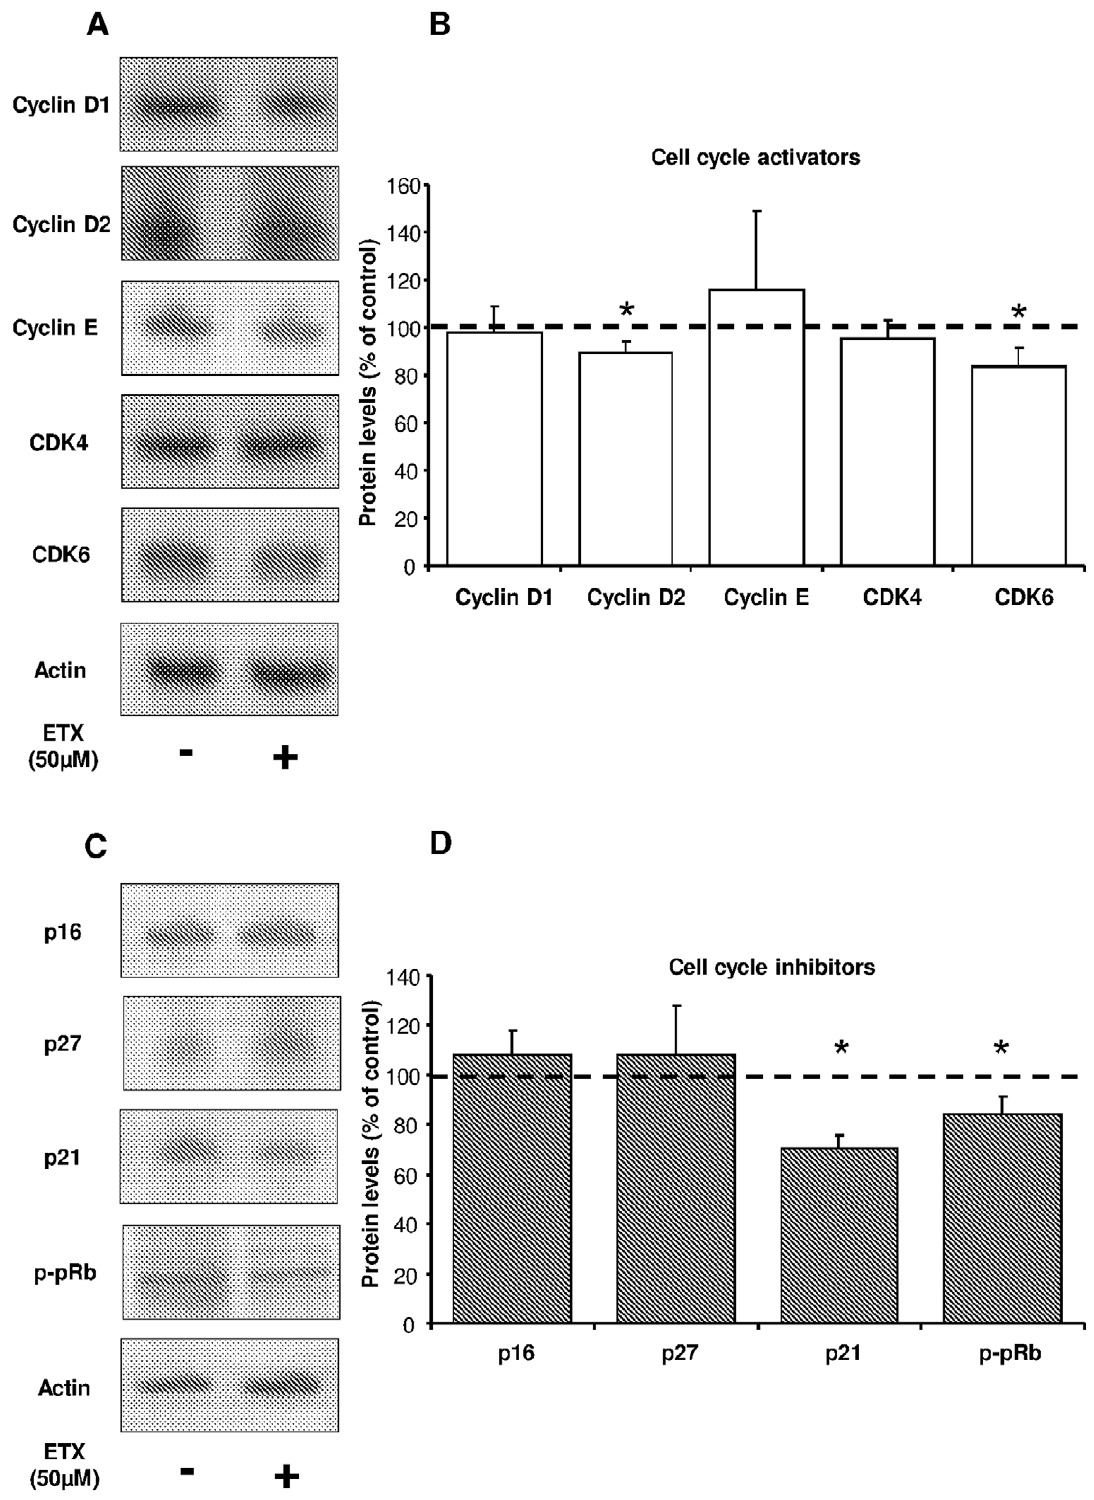
Figure 5. Effects of etomoxir on cell cycle regulatory proteins in myeloma cells. Western blot analysis of cell cycle regulatory proteins from etomoxir-treated myeloma cells. Cells were treated in the presence or absence of 50 m M etomoxir for 18 hours before harvesting the cells, preparation of cell extracts and detection of proteins by specific antibodies. Representative immunoblot of cell cycle activators ( A ) and inhibitors ( C ). Quantification of the total data set expressed as percentage of untreated cells ( B, D ). Mean 6 SEM for 4–6 independent experiments. *p , 0.05 versus untreated cells.